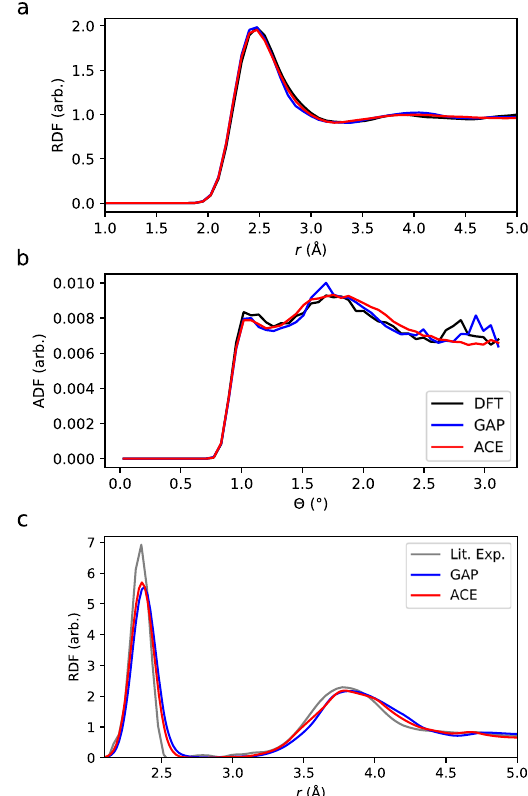
Fig. 8 Structural properties of liquid and amorphous Si. a Radial distribution function (RDF) and b angular distribution function (ADF) at P = 0 GPa and T = 2000 K. c Radial distribution function (RDF) for a 216-atom con fi guration generated by cooling liquid Si from 2000 to 500 K comparing ACE, GAP, and experimental The elastic constants for Si in the diamond structure are summarized in Table 1. Both ACE and GAP match the DFT reference within a few percent. Both ACE and GAP accurately describe the phonon spectrum in comparison to the DFT reference, with the band width of GAP showing a better match to DFT. The phonon dispersion of diamond for ACE and GAP and for other structures is shown in the Supplementary fi gures.